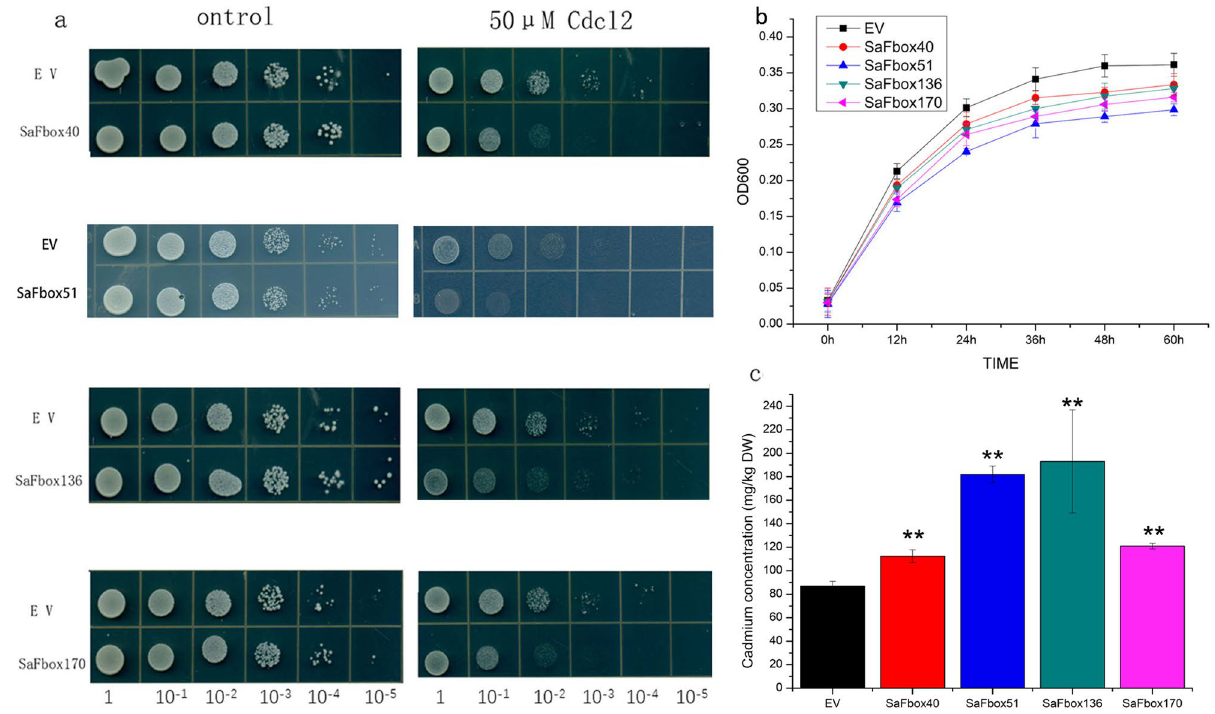
Figure 9. Effects of the overexpression of Sedum alfredii SaFbox40 , SaFbox136 , and SaFbox170 genes in yeast. ( a ) The growth of Δycf1 yeast cells carrying the pYes2.0 empty vector (control) is compared with that of cells carrying recombinant plasmids with SaFbox40 , SaFbox136 , or SaFbox170 . ( b ) Growth curves of transgenic yeast with SaFboxs or empty vector in SG-U liquid medium treated with Cd. ( c ) Cadmium accumulation of transgenic yeast were detected at logarithmic phase under 30 μM/L CdCl 2 . Bars indicate means ± standard deviations (SDs) of at least three independent biological replicates. Two asterisks indicate a significant difference at p < 0:01 compared with an empty